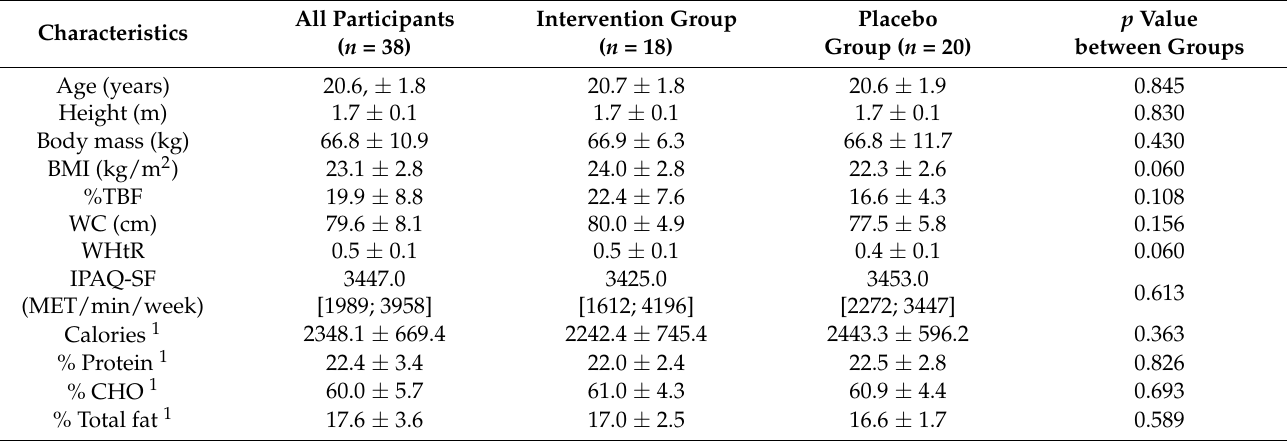
Table 1. Baseline characteristics of participants.